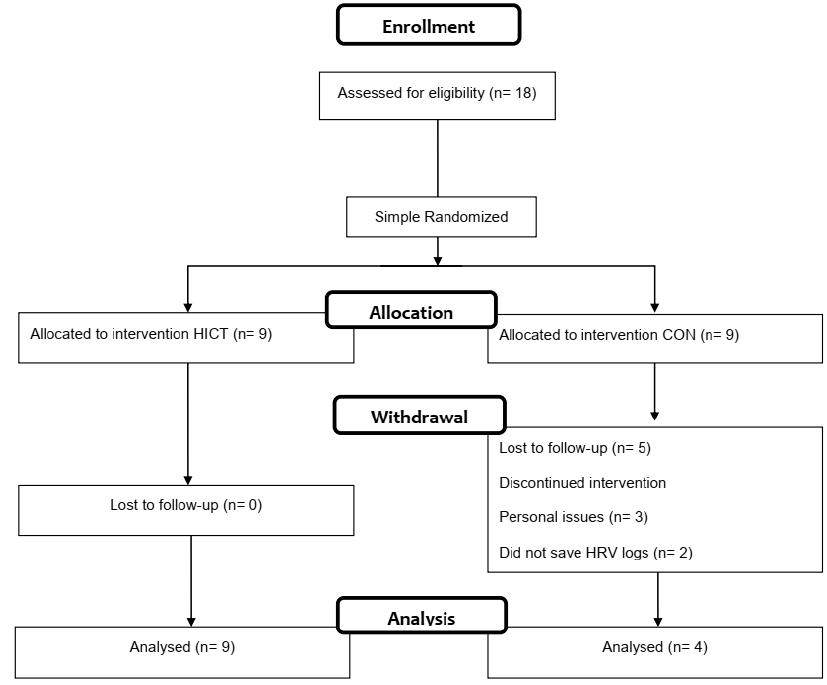
Figure 1. Flow chart of the intervention protocol.